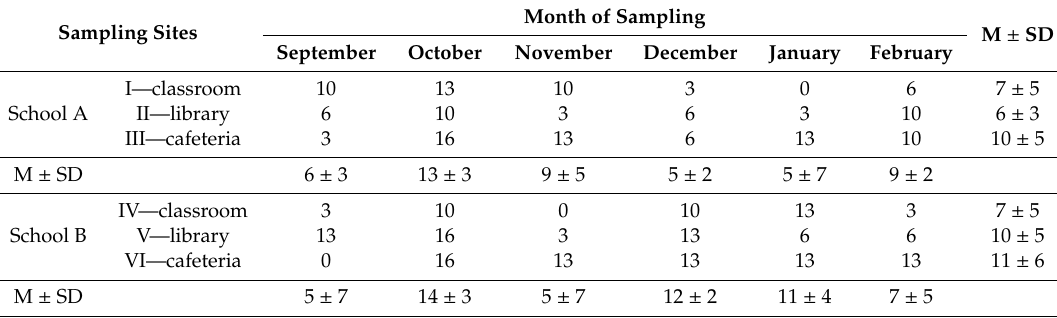
Table 5. Number of mannitol-positive staphylococci in air (CFU m − 3 ). Sampling Sites